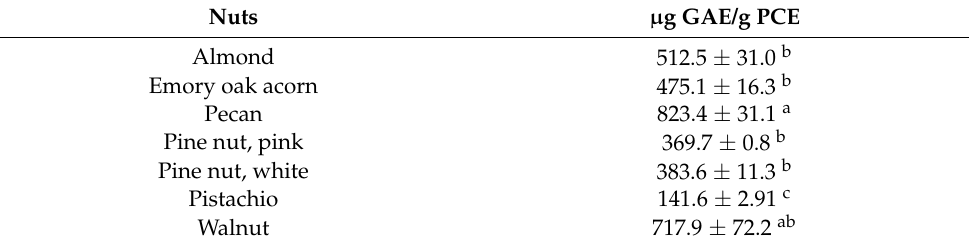
Table 3. Content of total phenolic compounds in PRE from nuts.